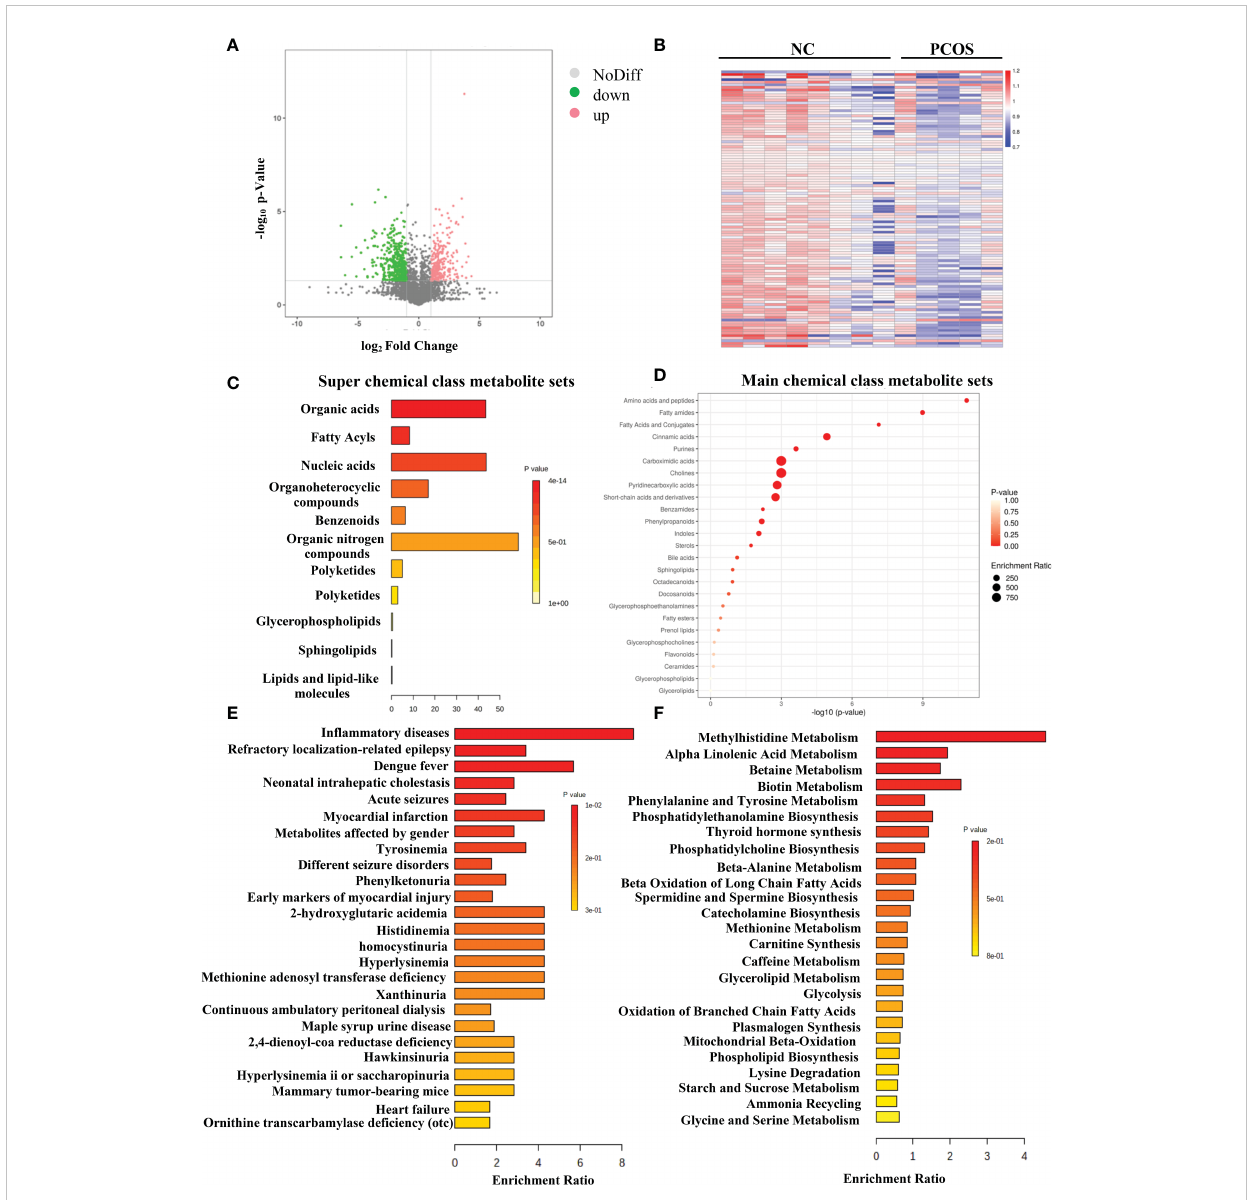
FIGURE 2 Differentially expressed metabolites in PCOS. (A) The volcano map of all metabolites expressed in NC and PCOS groups. (B) Hierarchical clustering analysis was used to assess signi fi cantly regulated metabolites between NC and PCOS groups. Increased and decreased metabolites are depicted by red and blue, respectively. (C) Super chemical class metabolite sets of the differential metabolites. (D) Main chemical class metabolite sets of the differential metabolites. (E) Enriched diseases clustering analysis. (F) Enriched metabolic pathway clustering